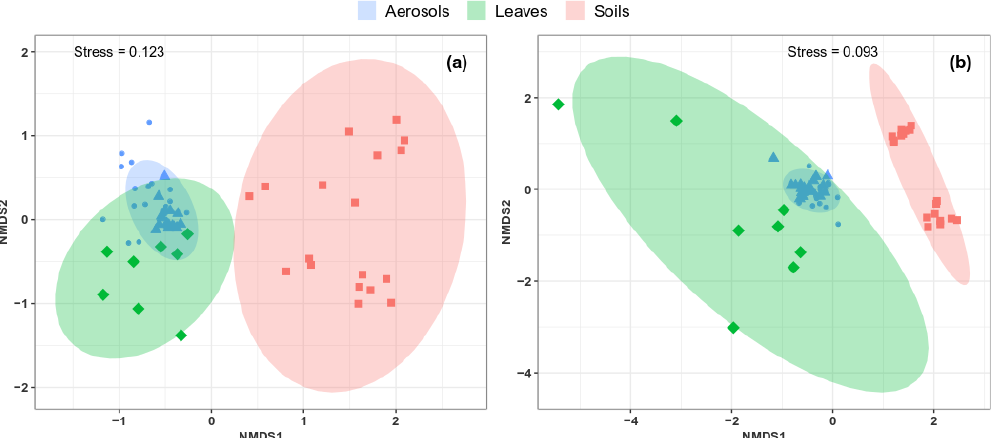
Figure 7. Compositional comparison of sample types in a NMDS scaling ordination. NMDS plots are constructed from a Horn distance matrix of MOTUs abundances for fungi (a) and bacteria (b) . Data sets are rarefied at the same sequencing depth. The stress values indicate an adequate two-dimensional picture of sample distribution. Ellipses represent 95% confidence intervals for the cluster centroids. Circular and triangular shapes highlight air PM 10 samples with background and peak SC concentrations,